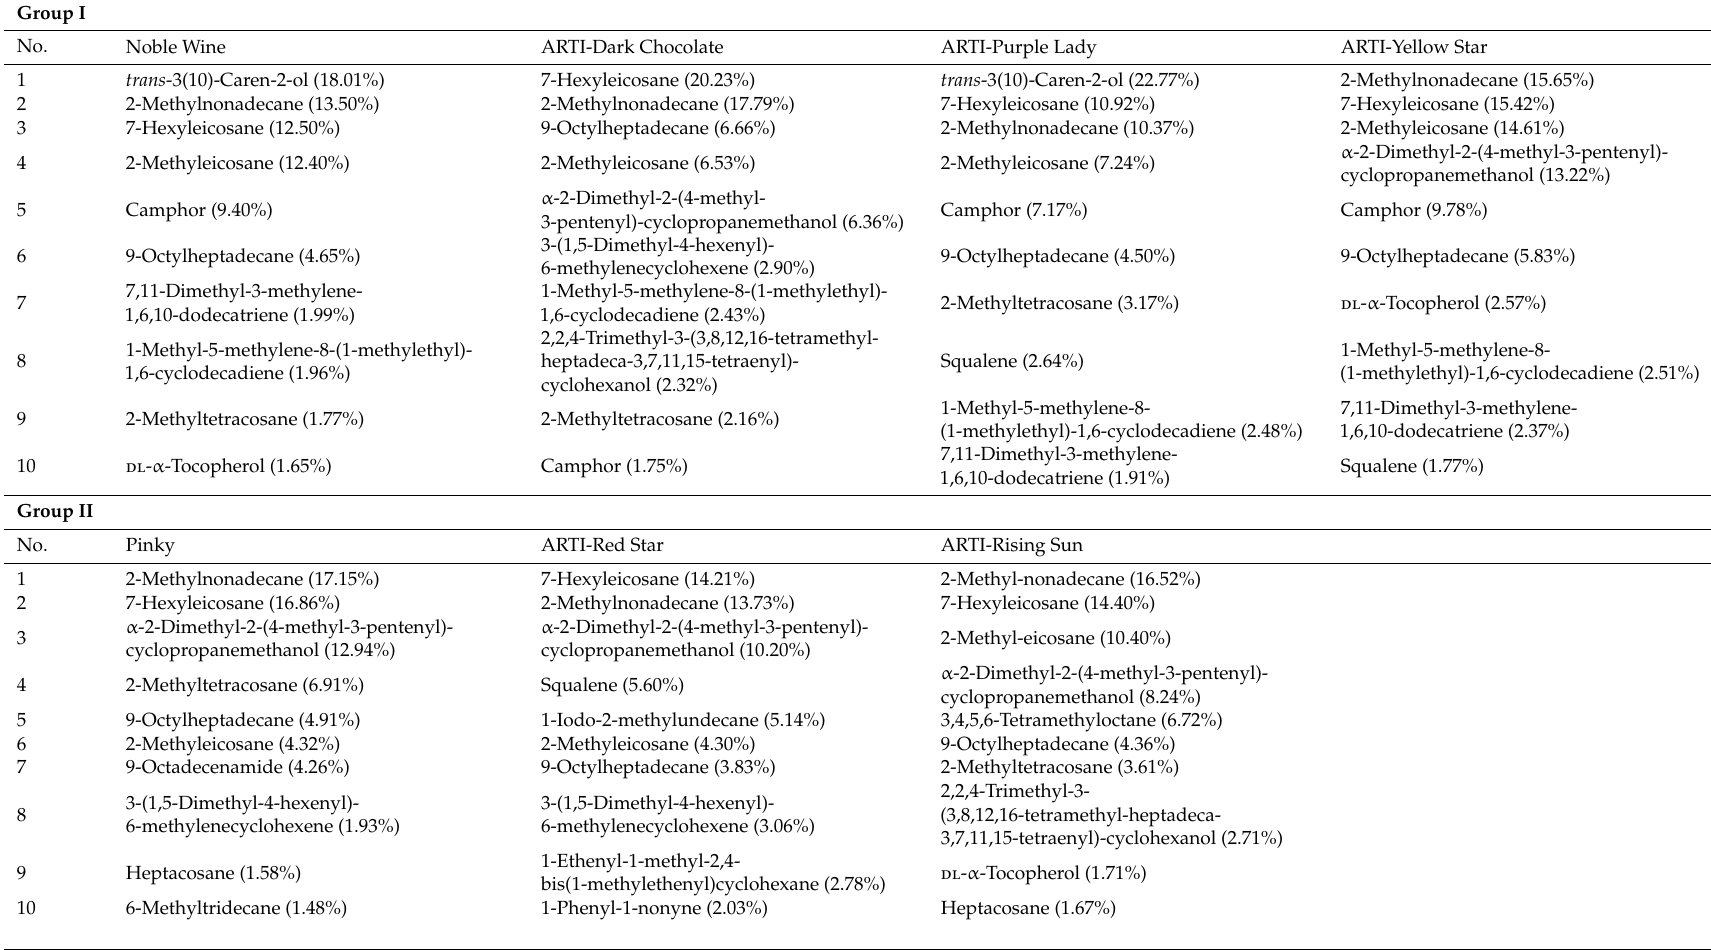
Table 3. Top 10 volatile compounds identified from the chrysanthemum